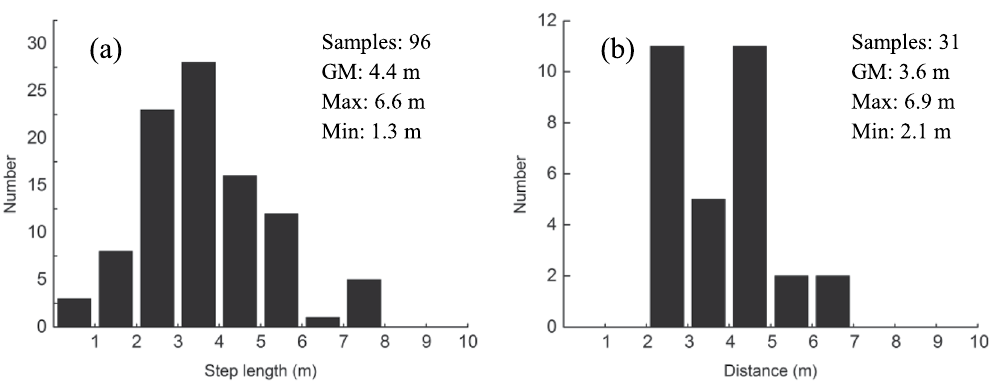
Figure 5. Histograms of ( a ) step length, and ( b ) distance from the center of space leader to the channel